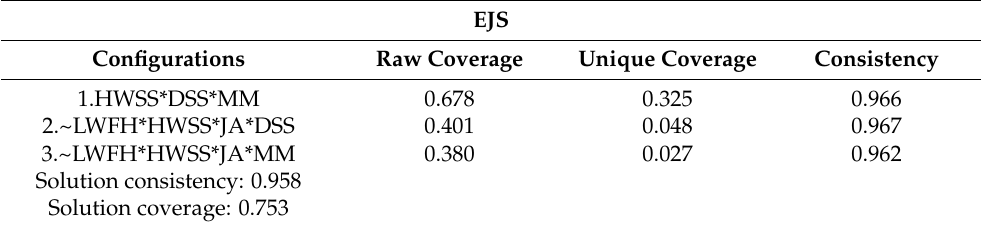
Table 5. Solutions for high EJS for sub ‐ sample 1.